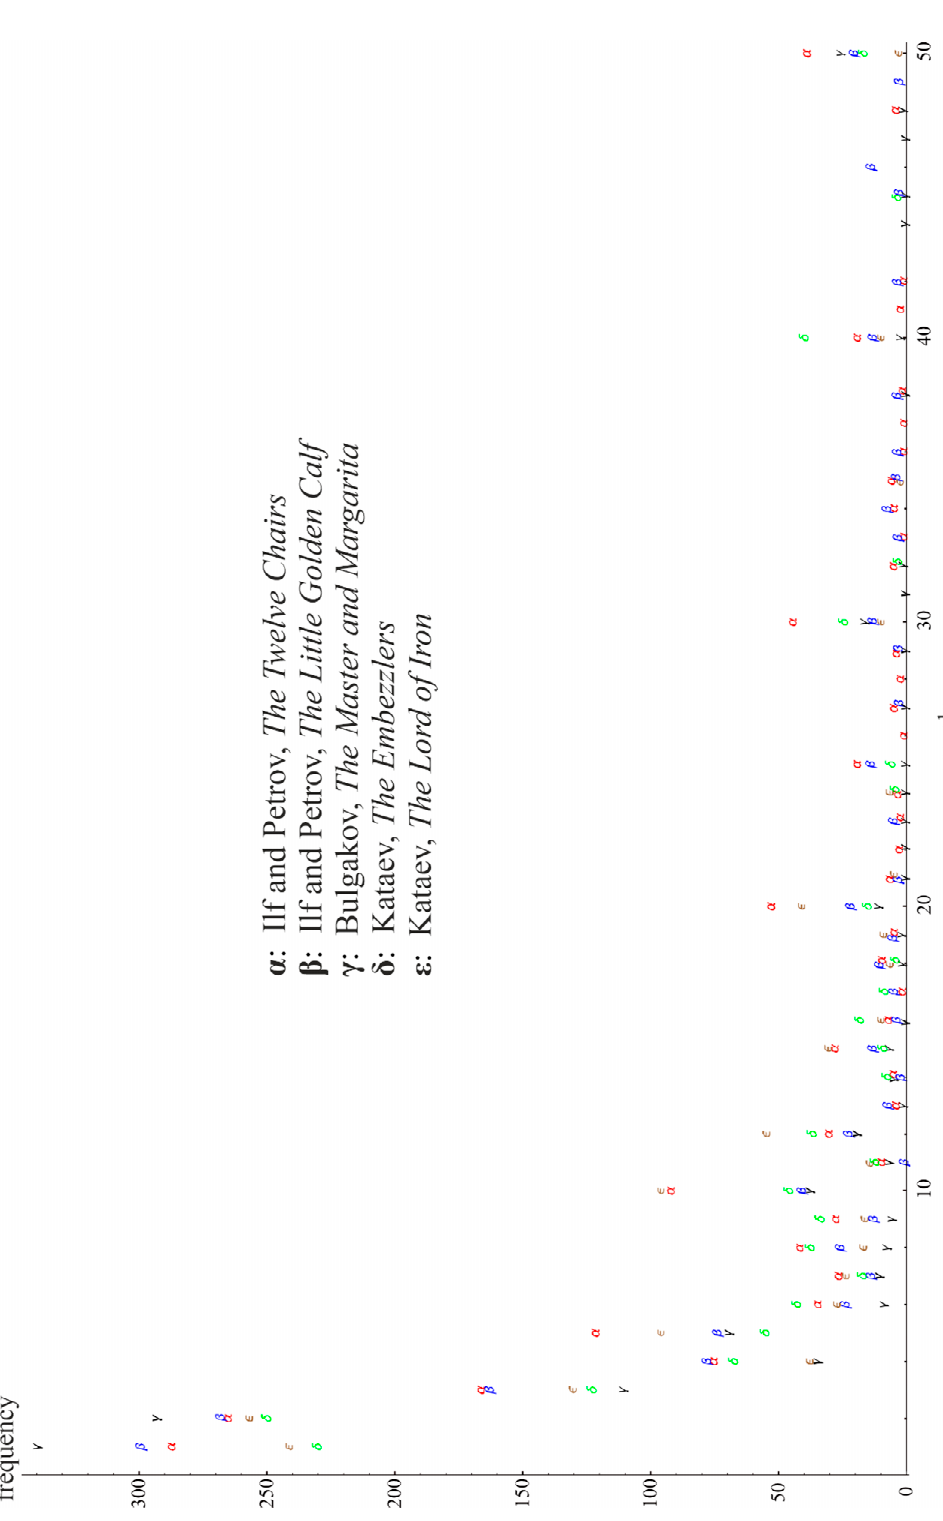
Figure 13. Frequency distribution of numerals in the texts by Ilf and Petrov, Bulgakov, and Kataev.